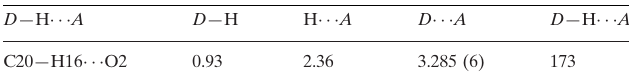
Hydrogen-bond geometry (A˚ , (cid:3)